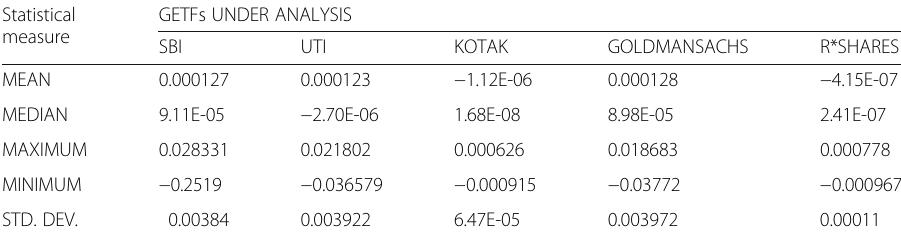
Table 1 Descriptive statistics of returns Statistical measure